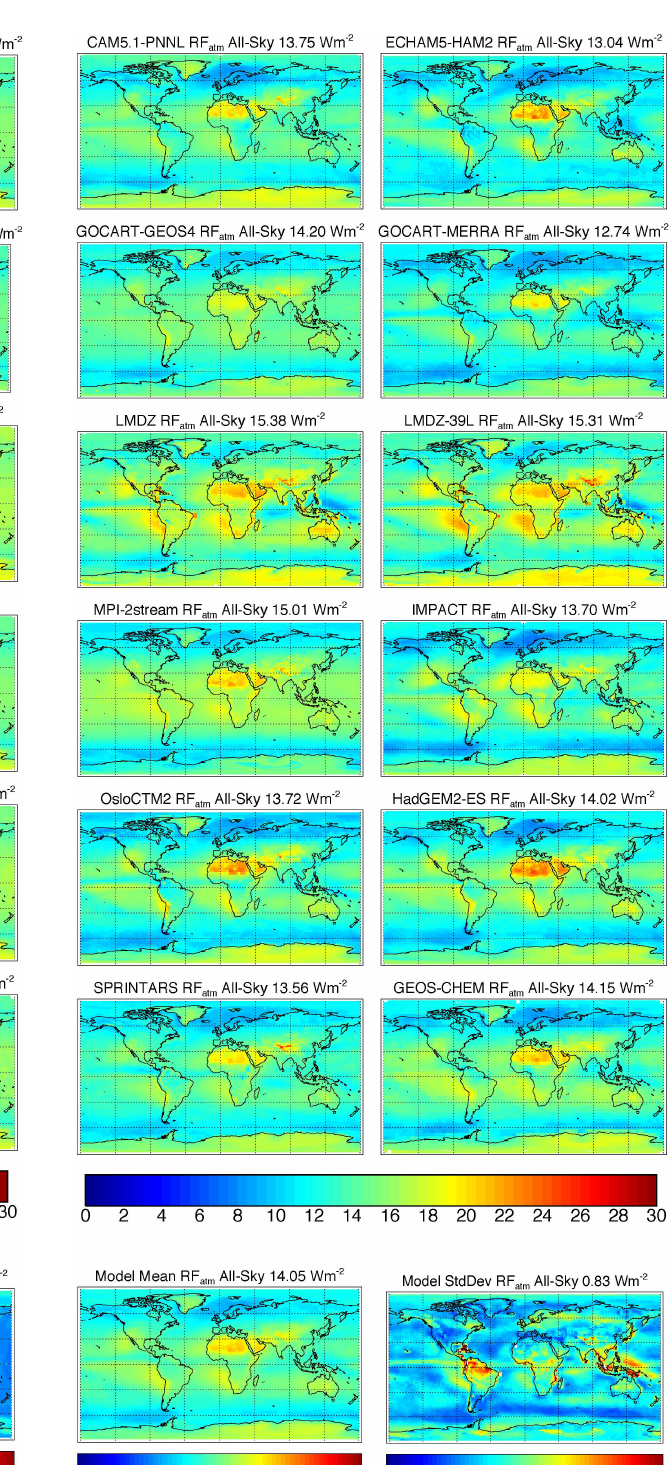
Fig. 15. Annual mean short-wave all-sky atmospheric radiative forcing (absorption) between experiments with SSA=0.8 and SSA=1.0 with holding ANG=1.0 constant